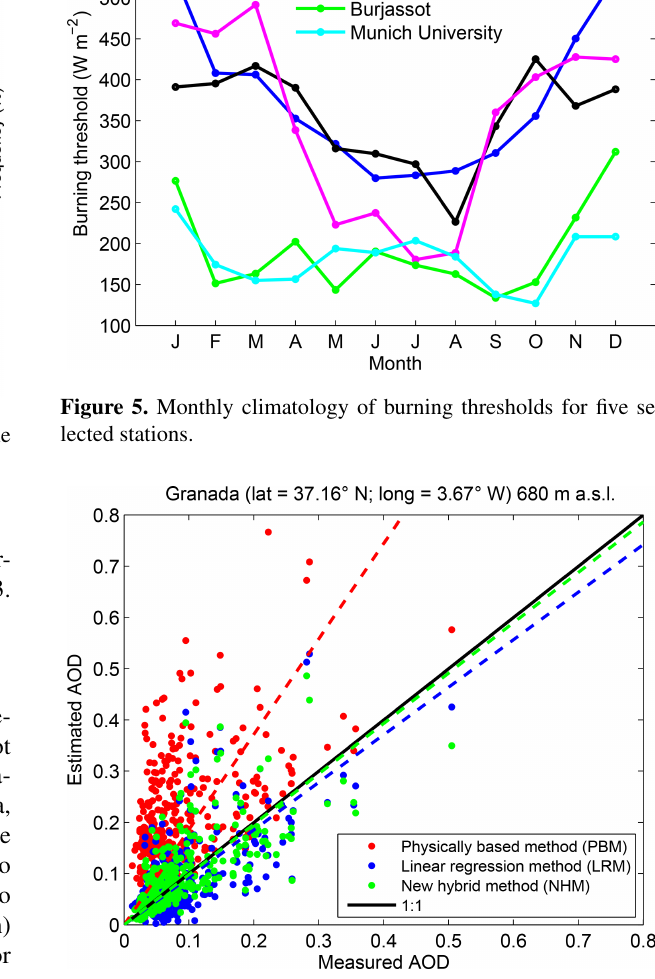
Figure 6. Scatterplot between measurements from AERONET and estimates from the PBM, LRM and NHM of daily AOD for Granada, Spain. The dashed colored line represents their corre- sponding linear